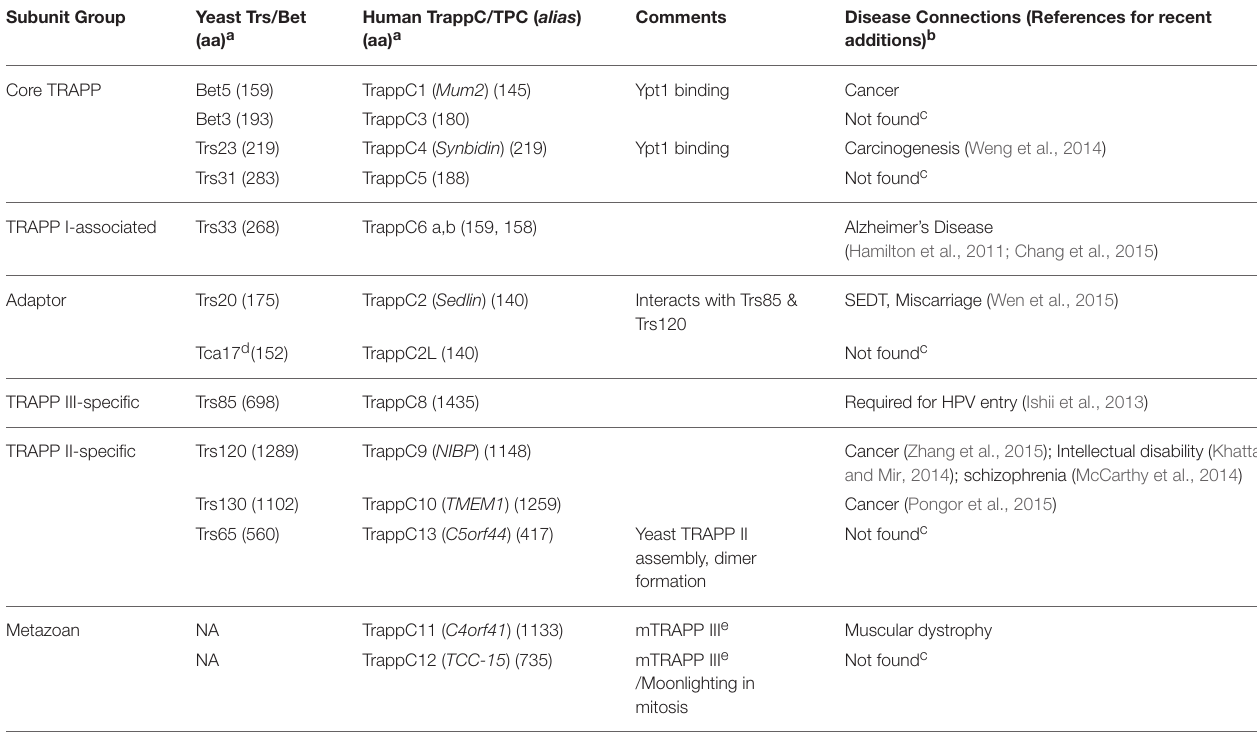
TABLE 1 | TRAPP complexes